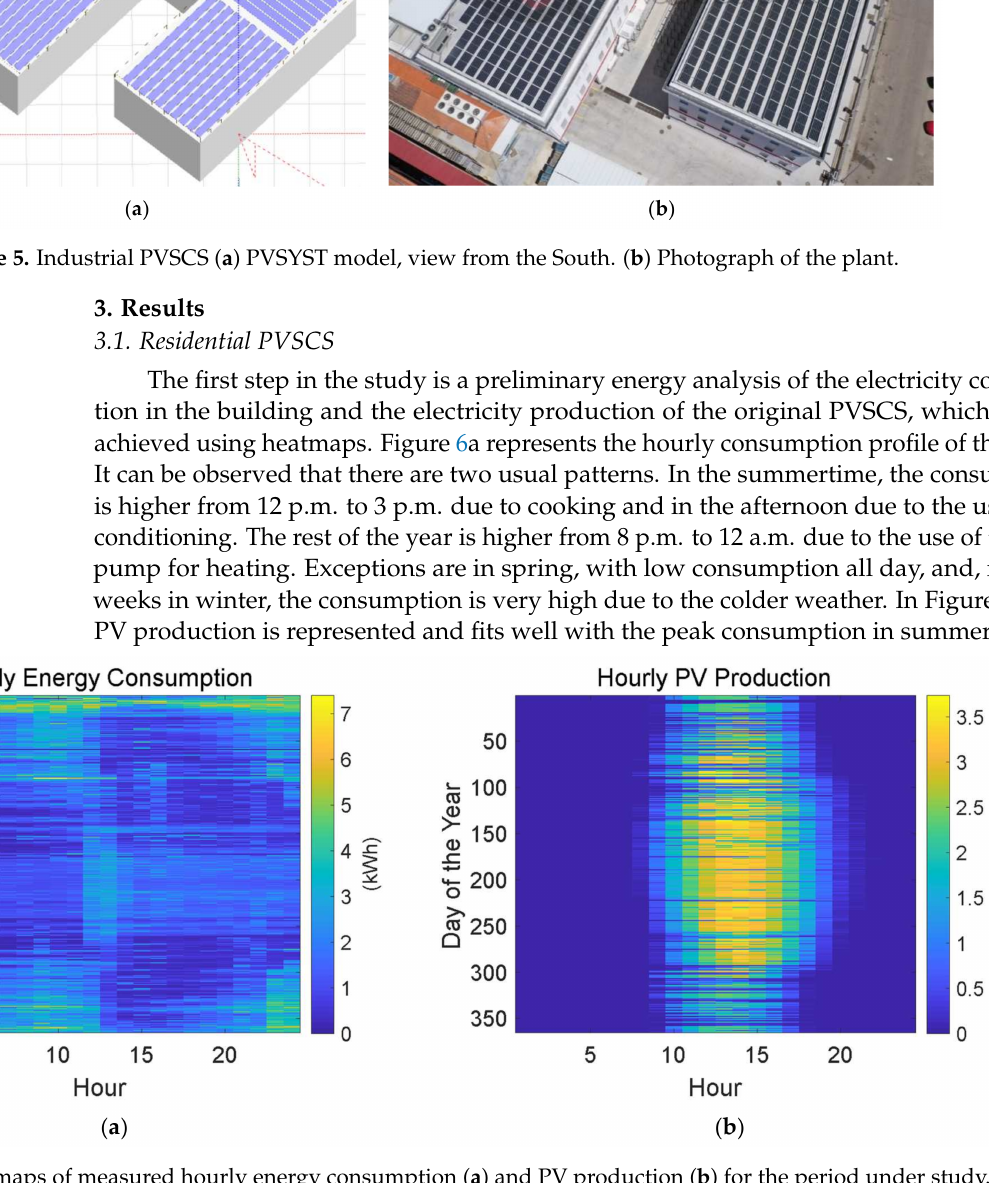
Figure 6. Heatmaps of measured hourly energy consumption ( a ) and PV production ( b ) for the period under